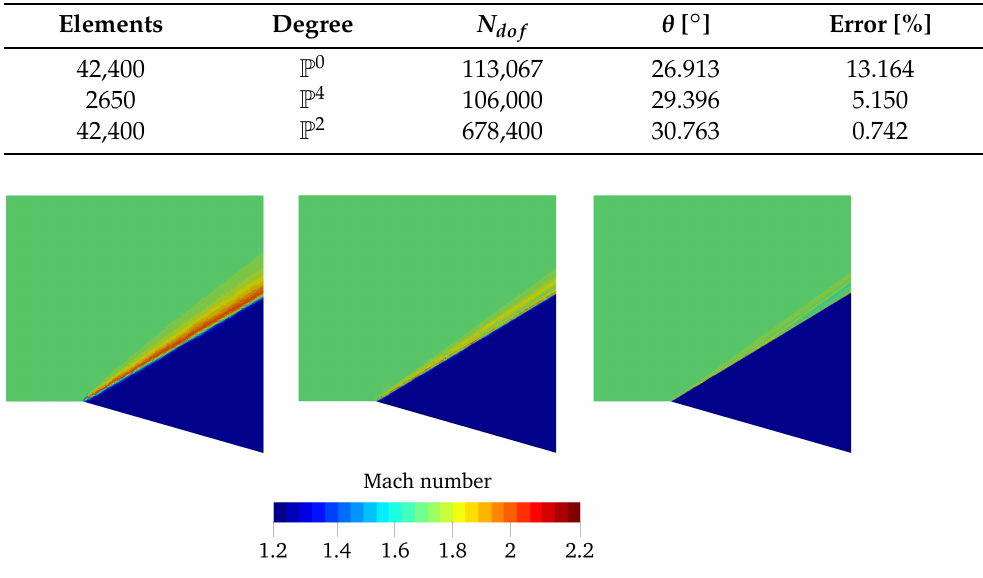
Figure 2. Wedge. Mach number contours predicted with the following set of mesh elements and polynomial order: 42,400 and P 0 ( left ), 2650 and P 4 ( center ), and 42,400 and P 2 ( right